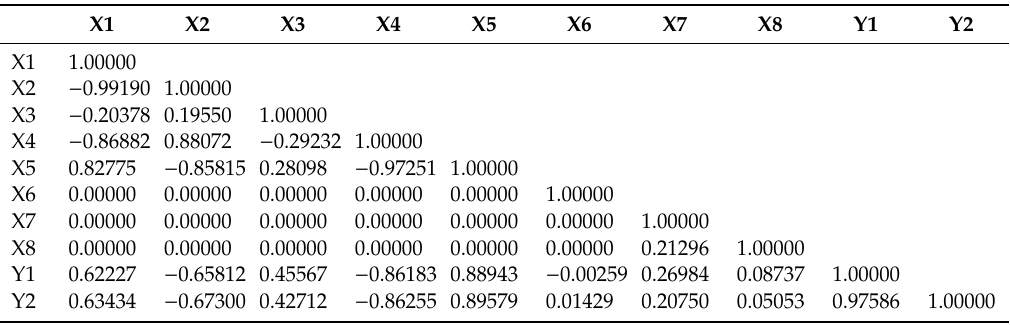
Table 8. Correlation